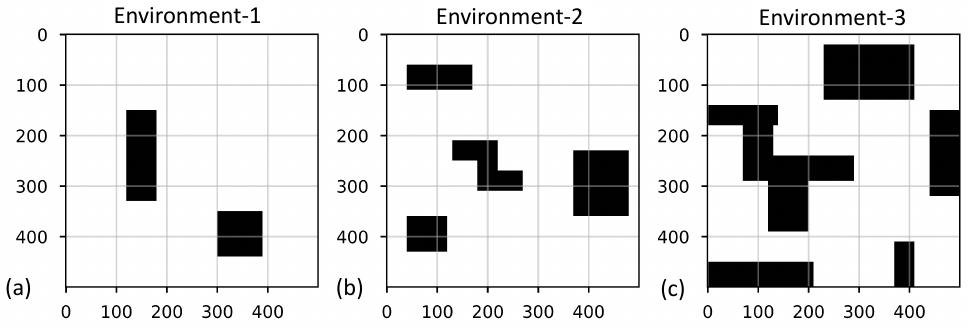
Figure 7. Simulation environments with different Obstacle Density (OD) 1 ( a ) (OD-7.56%), 2 ( b ) (OD-13.76%) and 3 ( c )